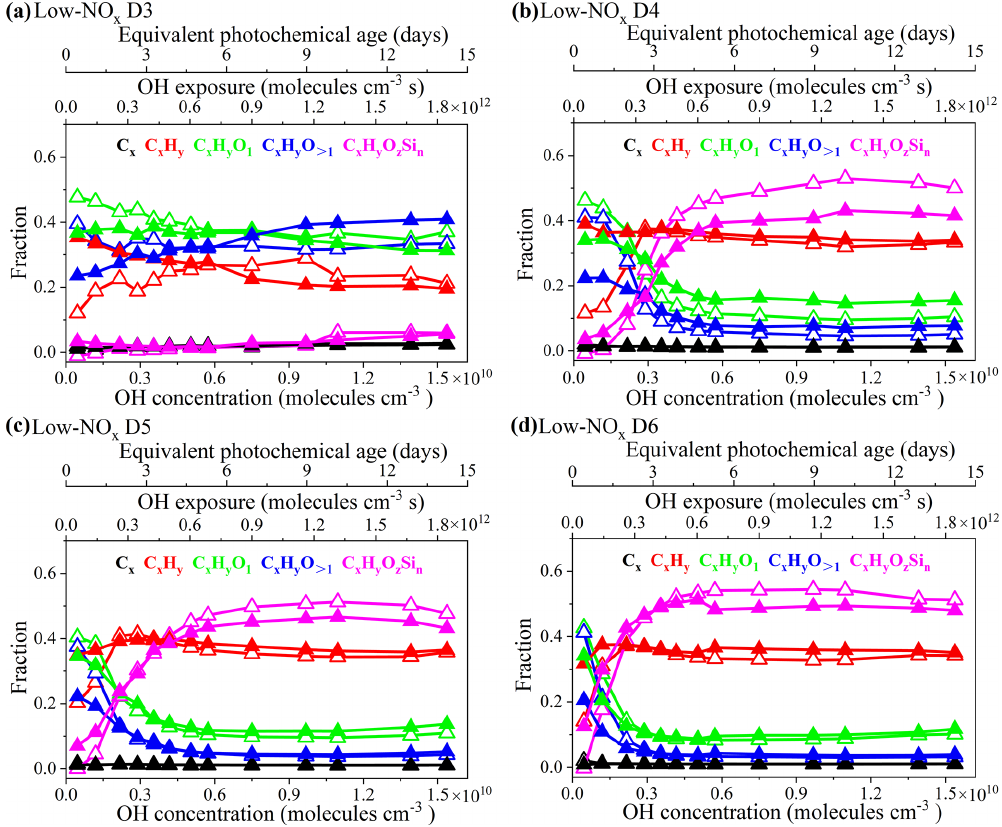
Figure 3. Fraction of C x , C x H y , C x H y O 1 , C x H y O > 1 and C x H y O z Si n ion groups for SOAs derived from the oxidation of cVMSs (a–d) by OH radicals at different photochemical ages under low-NO x conditions. Empty and solid triangles represent experimental data under unseeded and seeded conditions,